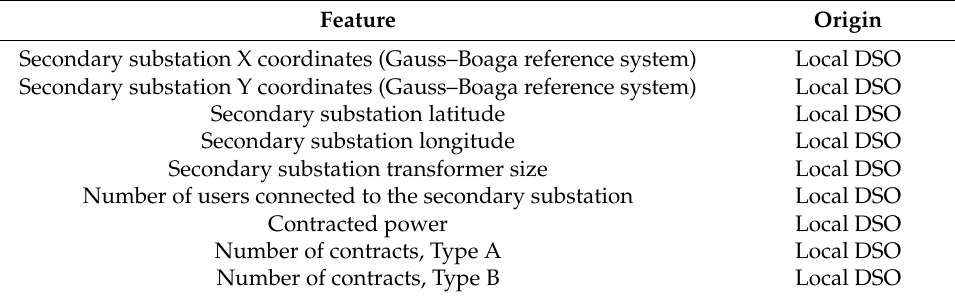
Table A1. List of the 85 features